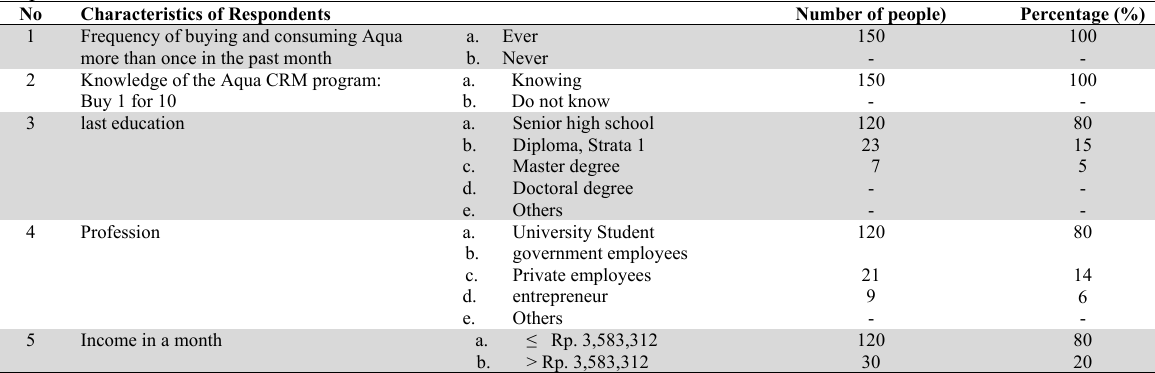
Respondent Profile